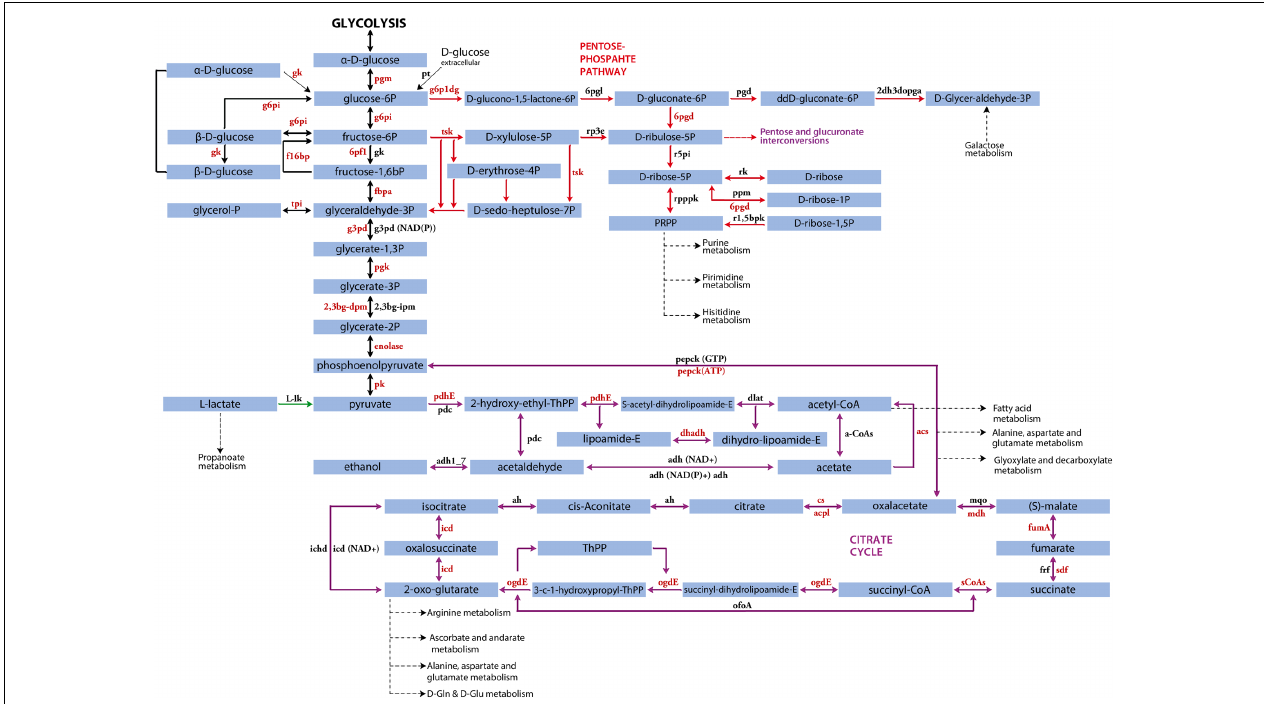
FIGURE 4 | Saprolegnia parasitica carbon metabolism. Shown are metabolites and enzymes of the carbon metabolism covering glycolysis, the pentose-phosphate pathway, and citrate cycle. Boxes represent metabolites, arrows indicate enzyme reactions. Enzymes enriched in S. parasitica mycelium are colored in red. pgm, phosphoglucomutase; gk, glucokinase; g6pi, glucose-6-phosphate isomerase; f1,6bp, fructose-1,6-bisphosphatase; fbpa, fructose-bisphosphate aldolase; tpi, triosephosphate isomerase; g3pd, glyceraldehyde 3-phosphate dehydrogenase; g3pd(NAD(P)), glyceraldehyde 3-phosphate dehydrogenase (NAD(P)); pgk, phosphoglycerate kinase; 2,3bg-dpm, 2,3-bisphosphoglycerate-dependent phosphoglycerate mutase; 2,3bg-ipm, 2,3-bisphosphoglycerate-independent phosphoglycerate mutase; pepck(GTP), phosphoenolpyruvate carboxykinase (GTP); pepc(ATP), phosphoenolpyruvate carboxykinase (ATP); pk, pyruvate kinase; 6pf1, 6-phosphofructokinase 1; pt, phosphotransferase; L -ld, L -lactate dehydrogenase; pdhE, pyruvate dehydrogenase E1 component; pdc, pyruvate decarboxylase; a-CoAs, acetyl-CoA synthetase (ADP-forming); dlat, pyruvate dehydrogenase E2 component (dihydrolipoamide acetyltransferase); acs, acetyl-CoA synthetase; adh (NAD+), aldehyde dehydrogenase (NAD+); adh (NAD(P)+), aldehyde dehydrogenase (NAD(P)+); adh, aldehyde dehydrogenase; adh1_7, alcohol dehydrogenase 1/7; g6p1dg, glucose-6-phosphate 1-dehydrogenase; 6pgl, 6-phosphogluconolactonase; 6pgd, 6-phosphogluconate dehydrogenase; tsk, transketolase; rp3e, ribulose-phosphate 3-epimerase; r5pi, ribose 5-phosphate isomerase A; rk, ribokinase; rpppk, ribose-phosphate pyrophosphokinase; ppm, phosphopentomutase; r1,5bpk, ribose 1,5-bisphosphokinase; pgd, phosphogluconate dehydratase; 2dh3dopga, 2-dehydro-3-deoxyphosphogluconate aldolase; pfoA, pyruvate ferredoxin oxidoreductase alpha subunit; dhadh, dihydrolipoamide dehydrogenase; ah, aconitate hydratase; cs, citrate synthase; acpl, ATP citrate (pro-S)-lyase; mdh, malate dehydrogenase; mqo, malate dehydrogenase (quinone); fumA, fumarate hydratase, class I; sdf, succinate dehydrogenase (ubiquinone) flavoprotein subunit; frf, fumarate reductase flavoprotein subunit; sCoAs, succinyl-CoA synthetase alpha subunit; odgE, 2-oxoglutarate dehydrogenase E2 component (dihydrolipoamide succinyltransferase); dld, dihydrolipoamide dehydrogenase; ofoA, 2-oxoglutarate ferredoxin oxidoreductase subunit alpha; ogdE, 2-oxoglutarate dehydrogenase E1 component; icd, isocitrate dehydrogenase; icd (NAD+), isocitrate dehydrogenase (NAD+); ichd, isocitrate–homoisocitrate